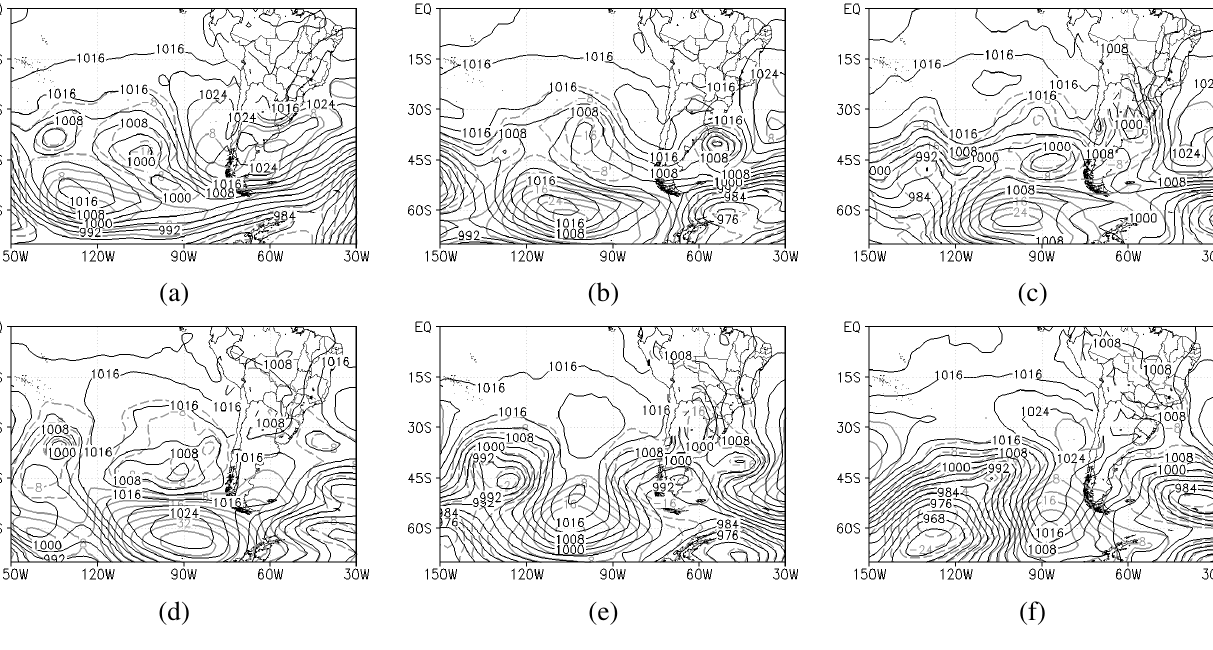
Fig. 10 – Same as in Fig. 8 except for the mean sea-level pressure (hPa). Fig. 10. Same as in Fig. 8 except for the mean sea-level pressure